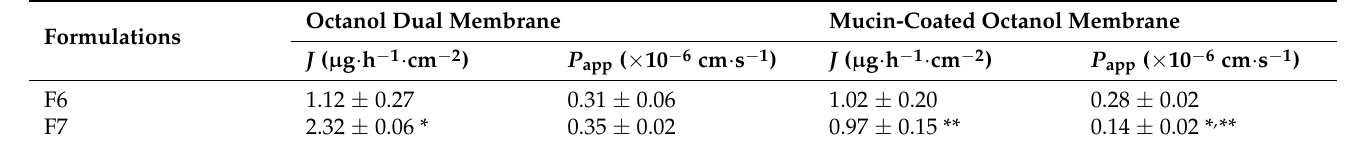
Table 5. The J and P app of FE-loaded EuNP eye drop formulations through artificial membranes. Octanol Dual Membrane Formulations